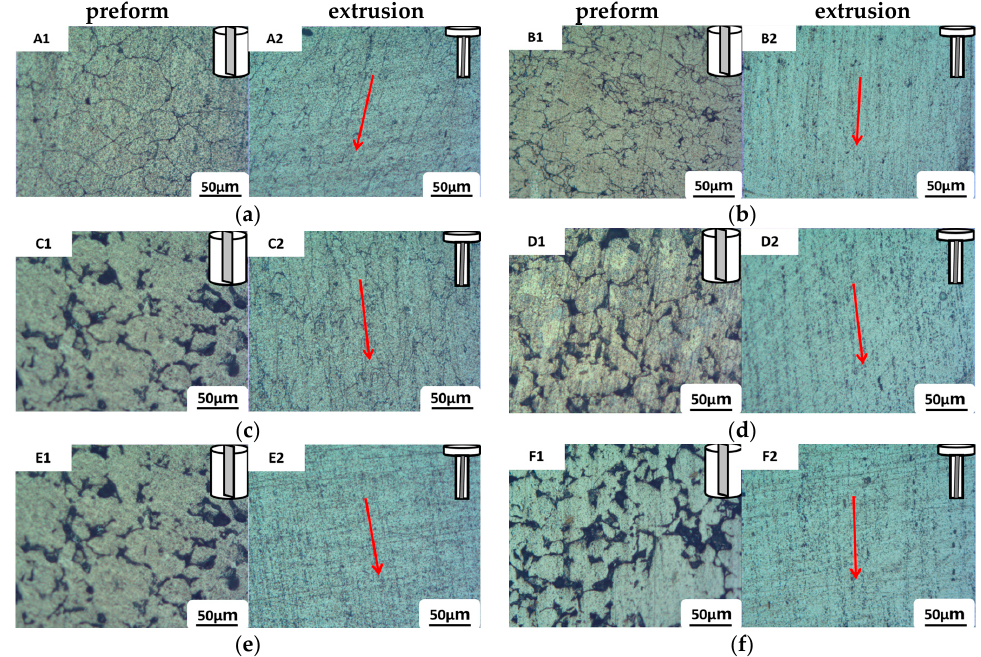
Figure 13. Microstructures after extrusion (520 °C, R = 4): ( a ) Pure Al6061; ( b ) 1 vol %; ( c ) 3 vol %; ( d ) 5 vol %; ( e ) 7 vol %, and ( f ) 10 vol %.